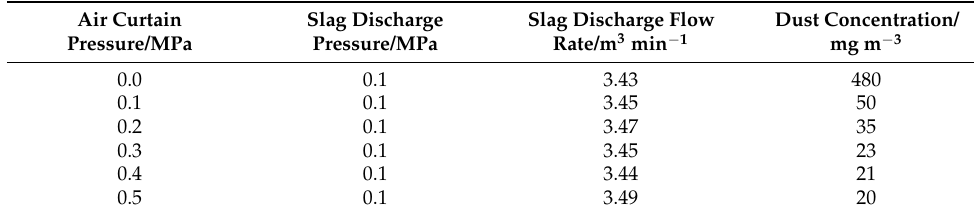
Table 3. Dust control effect with the slag discharge pressure at 0.1 MPa.